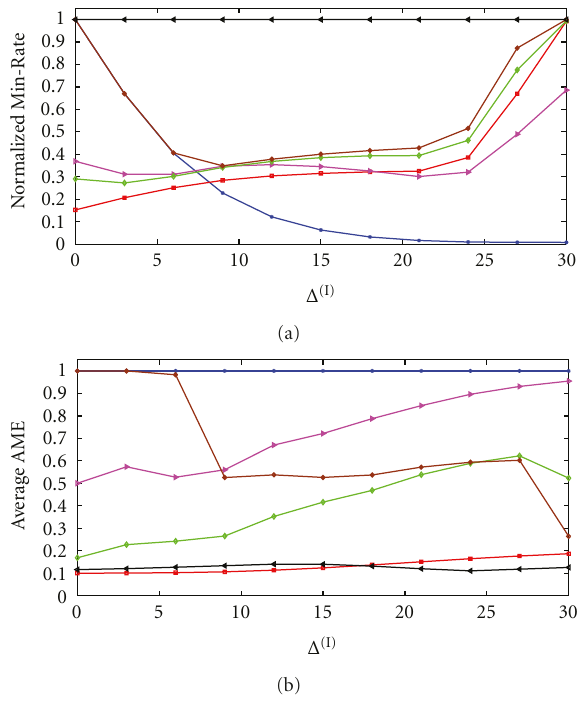
Figure 2: Experimental results for Model I: (a) Normalized Min- Rate versus Δ (I) ; (b) Average AME versus Δ (I) . The number of users is K = 10. Note that Δ (I) is expressed in dB, and for each Δ (I) > 0 the reported results are obtained from N r = 10 4 runs. The following MA methods are compared (for each method we indicate the color and the marker symbol used in plots): TS (black left-pointing triangle), OMA ≡ BORG K/ 1 (blue asterisk), BORG K/ 2 (magenta right-pointing triangle), BORG K/ 3 (green diamond), SIC ≡ BORG K/K (red square), and BORG ∗ K (brown